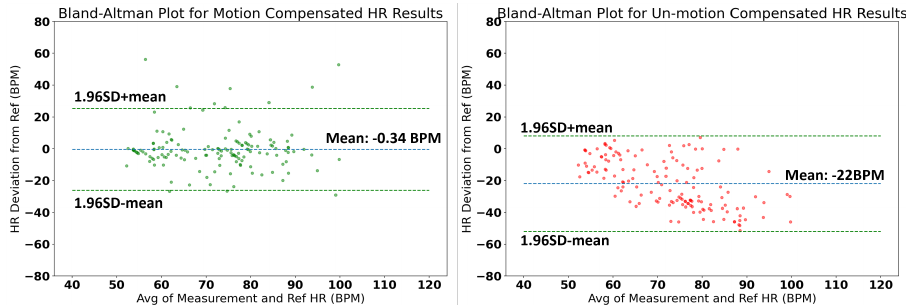
Figure 16. Bland–Altman plot of HR measurements when participants sit in the passenger seat on local road conditions with motion compensation ( left ) and without motion compensation ( right ).